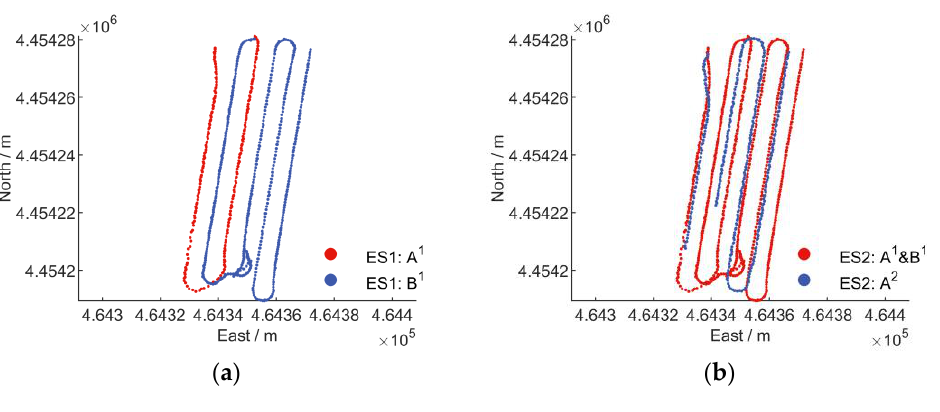
Figure 17. Trajectory of ( a ) ES1 and ( b ) ES2.